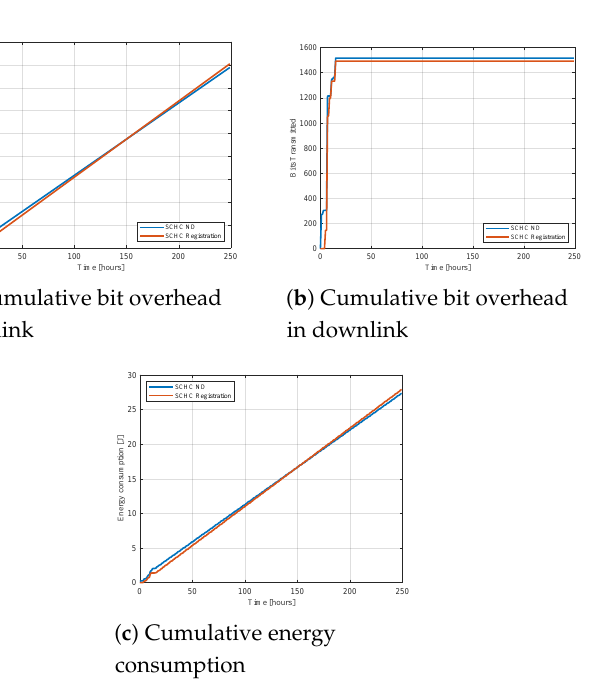
Figure 20. The cumulative bit and energy overhead for both dynamic solutions for a LoRa SF12